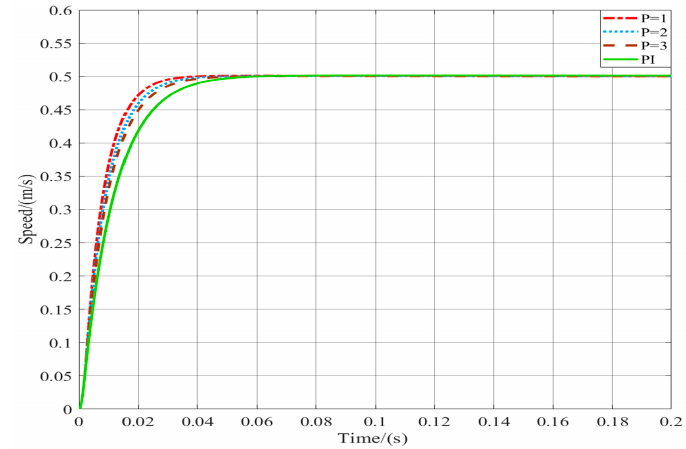
Figure 3. Speed tracking for proportional-integral (PI) and composite controllers (without load